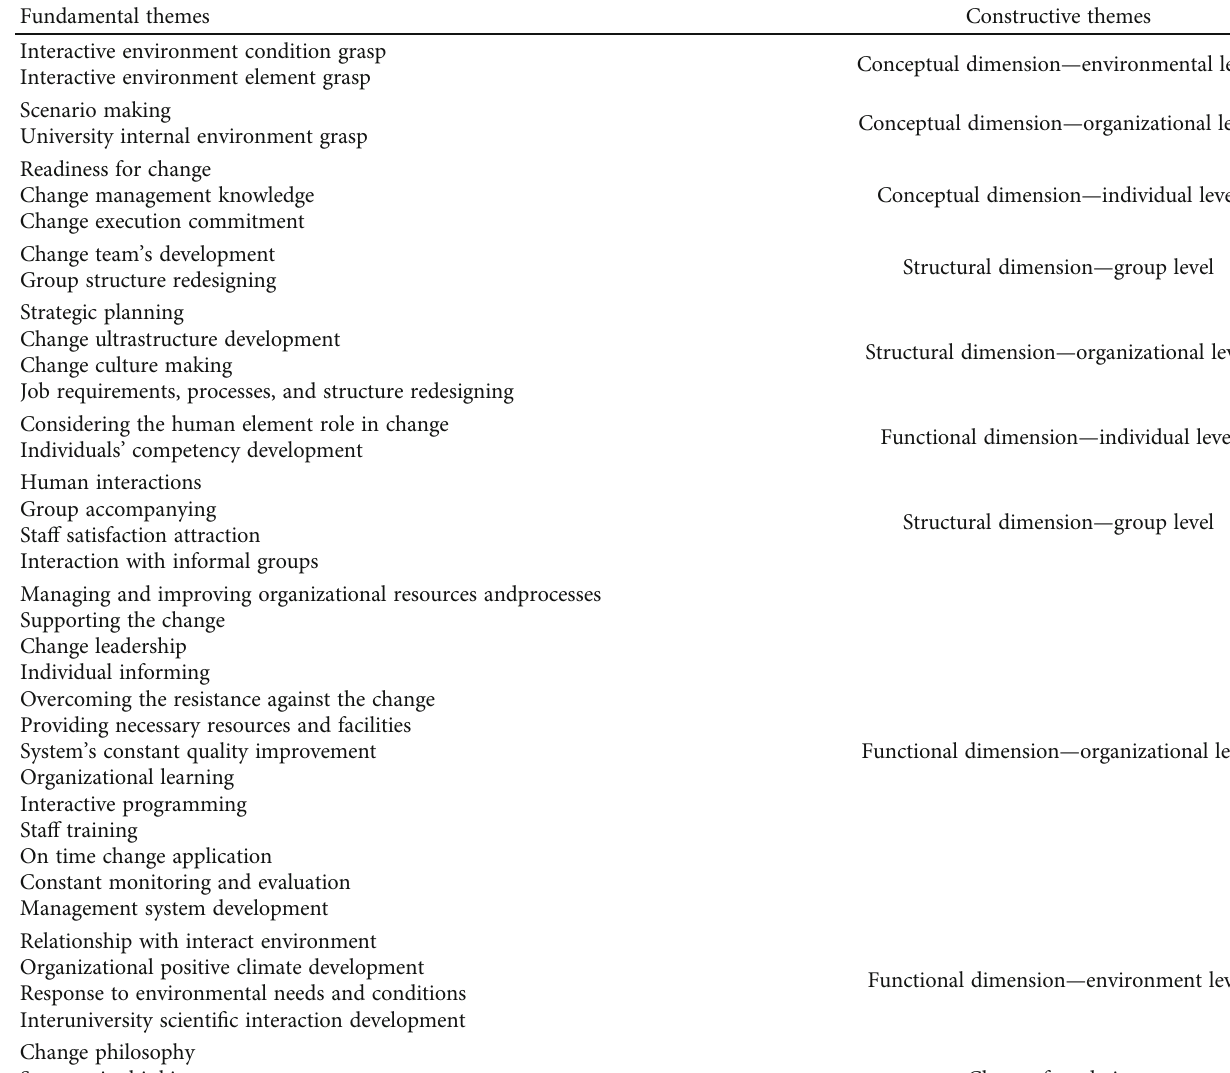
Table 2: Change climate organizing